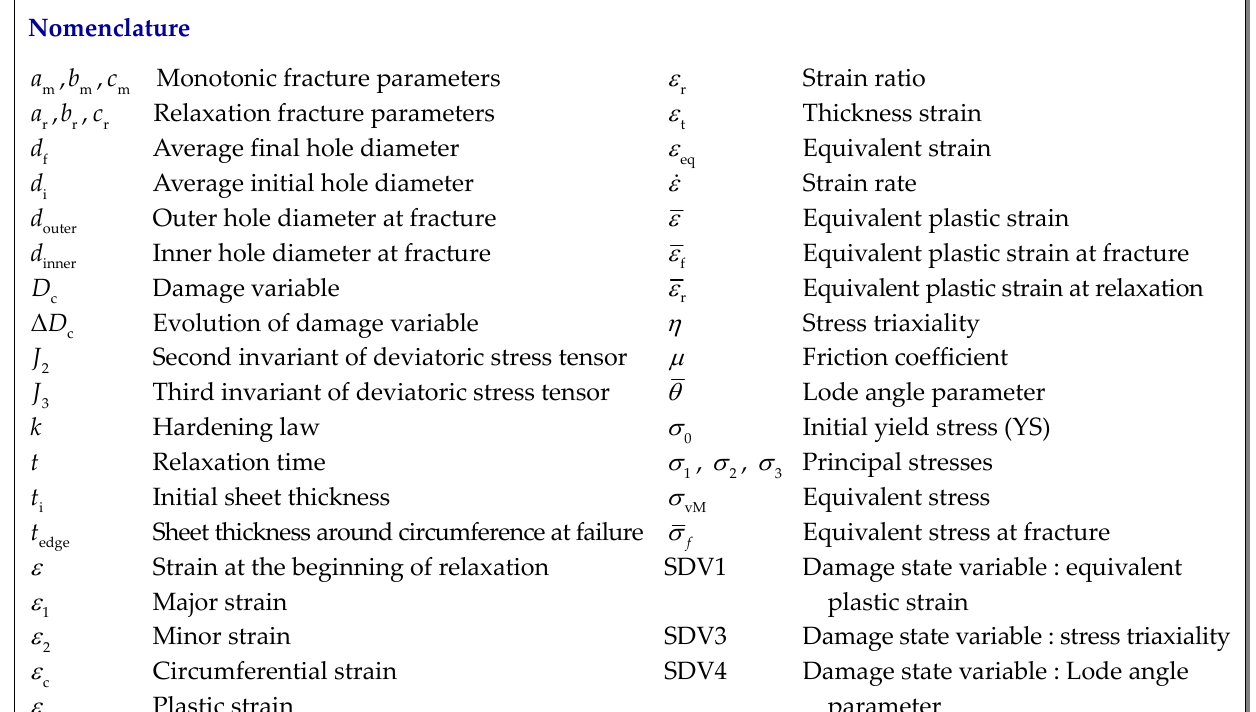
Damage state variable : Lode